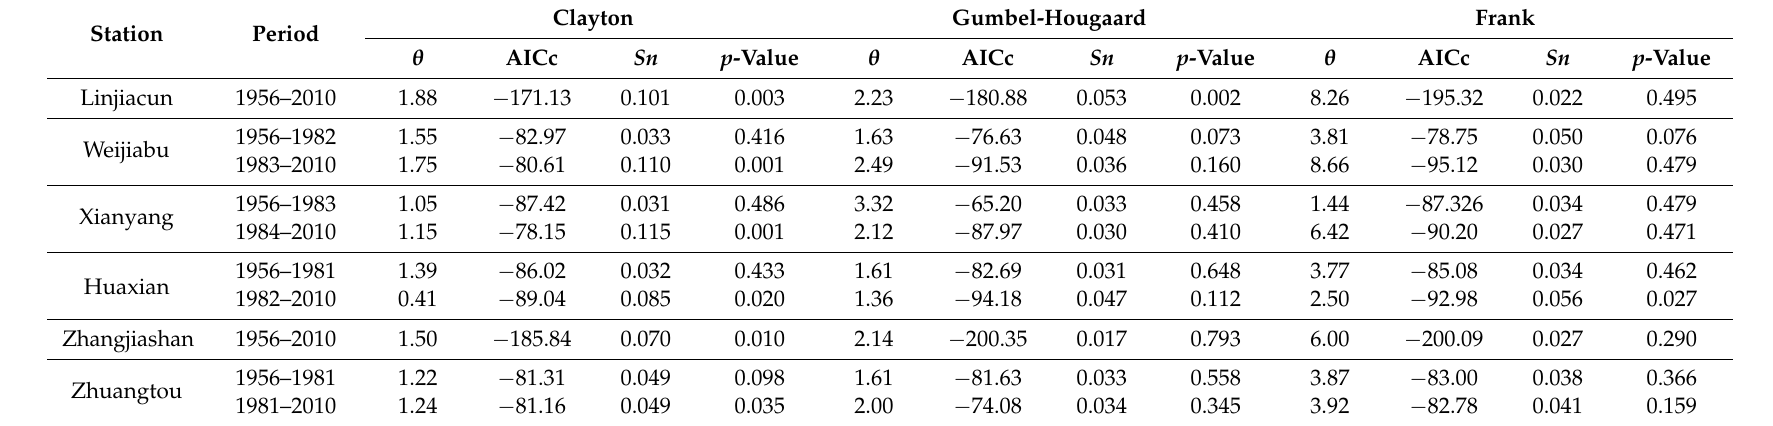
Table 5. The goodness-of-fit test, AICc and parameters of copula